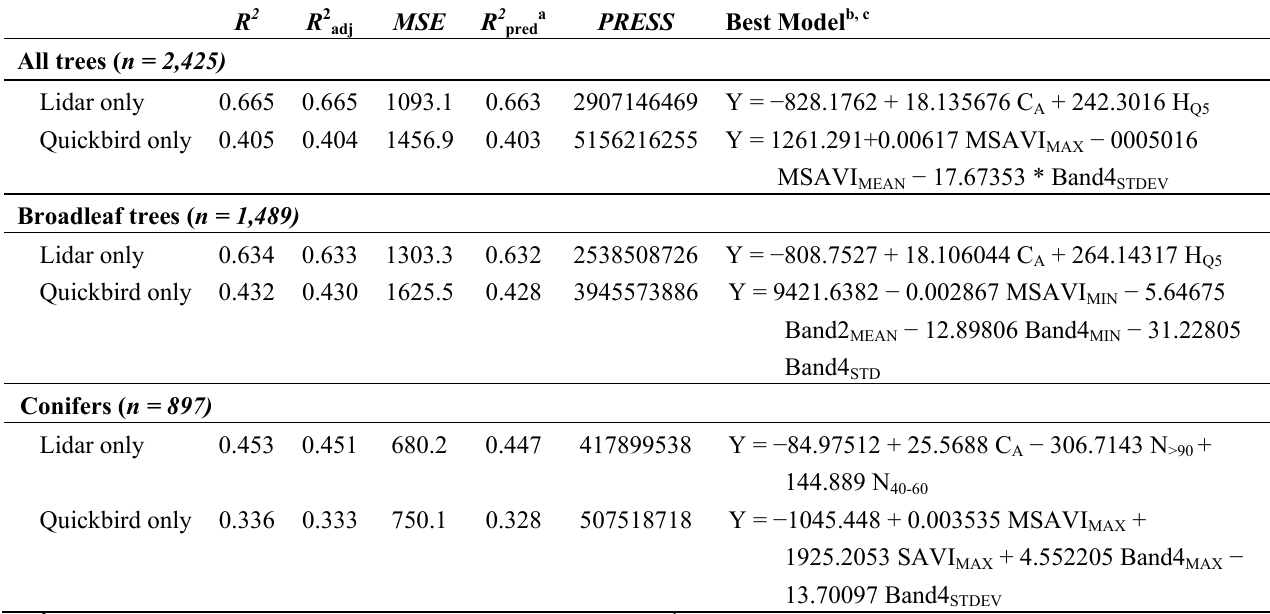
Table 10. Results of regression analysis of aboveground biomass (kg) of individual trees.